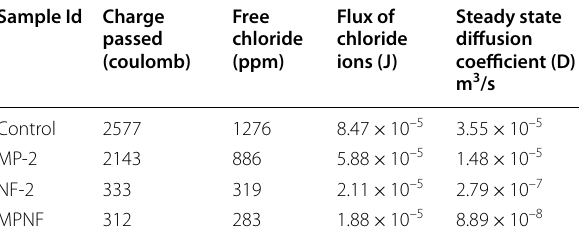
Table 3 Chloride diffusion